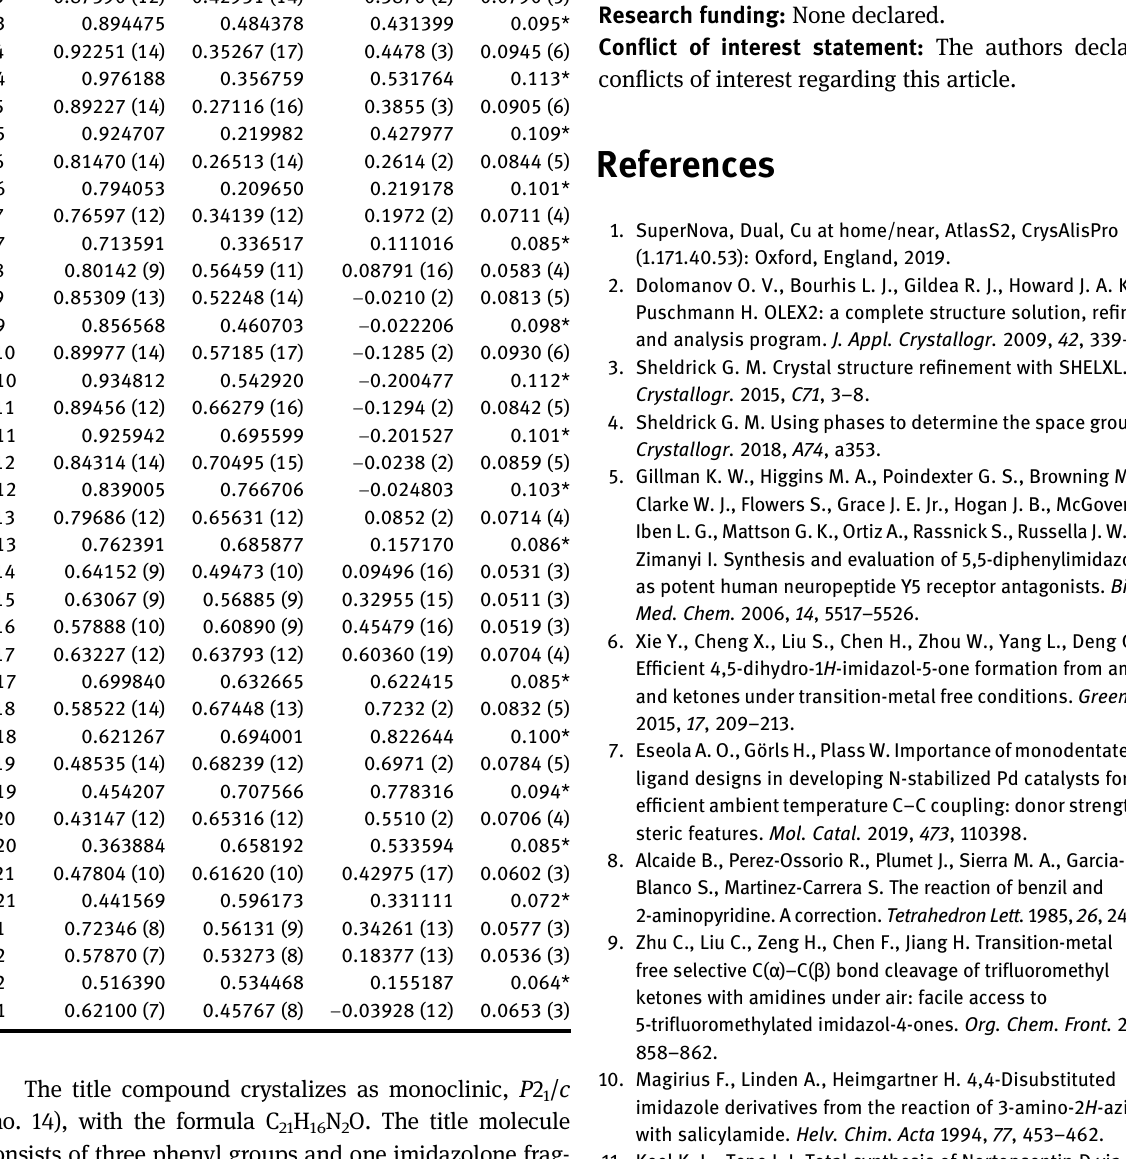
The title compound crystalizes as monoclinic, P 2 (no. 14), with the formula C consists of three phenyl groups and one imidazolone frag- ment. Two identical molecules are connected by two N2 – H2 / O1 hydrogen bonds to generate one dimer, which was